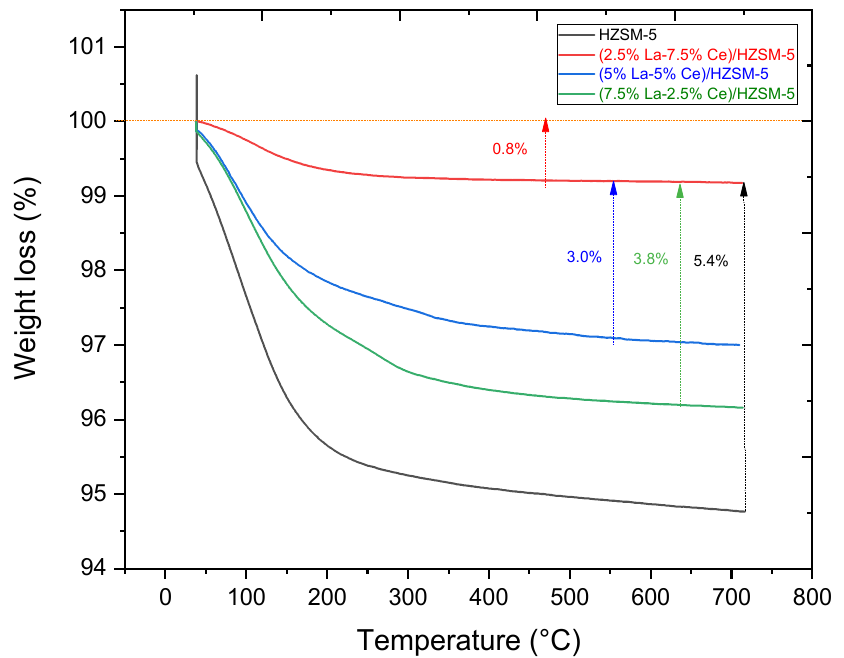
Figure 9. TGA of the fresh parent HZSM-5 and fresh Lanthanum-Cerium-modified HZSM-5 with different loading weight percentages.